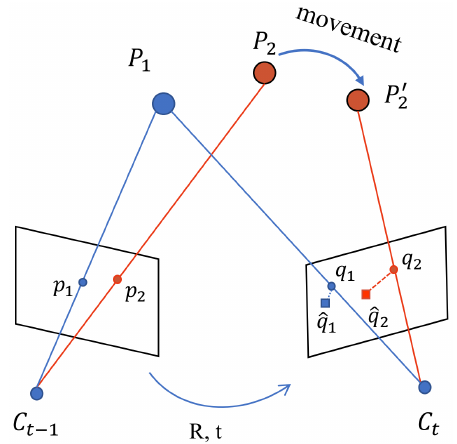
Figure 5. Different offset vectors of static points and dynamic points. C t − 1 and C t denote the camera center position at different times. q 1 − (cid:98) q 1 and q 2 − (cid:98) q 2 represent the offset vectors of static point P 1 and dynamic point P 2 in the current frame.